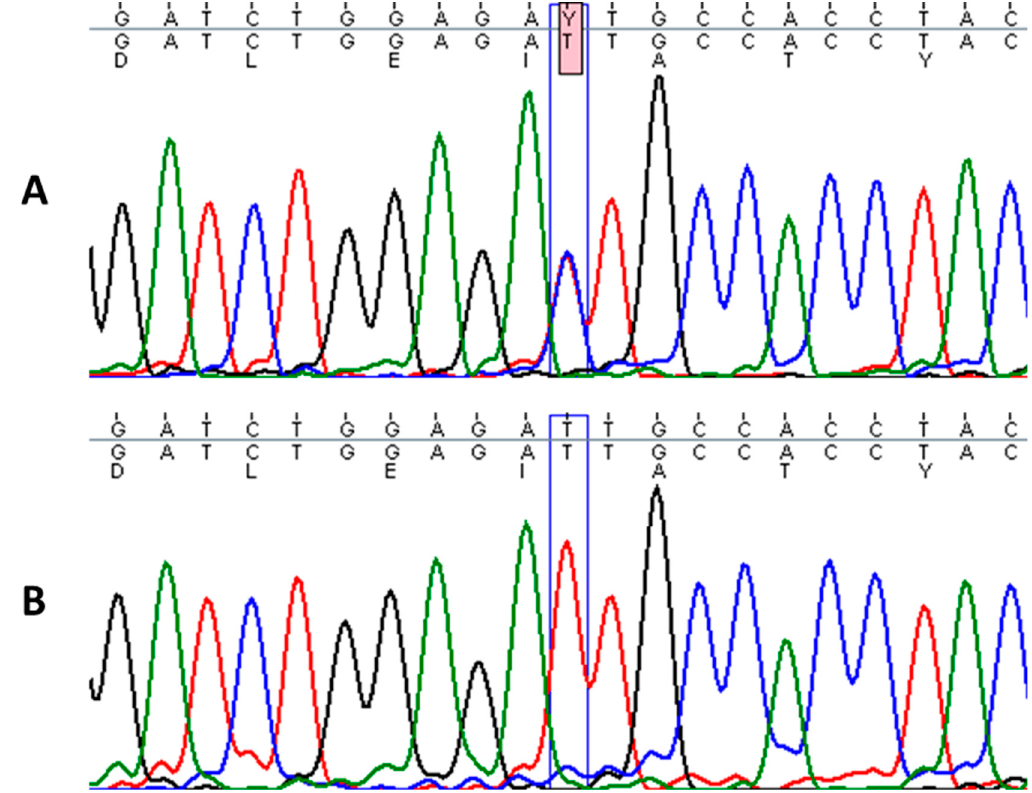
Figure 3. Sequence analysis of the affected patient with heterozygous mutation c.1436T > C in KRT1 gene ( A ) and homozygous wild-type sequence in a healthy individual ( B ).